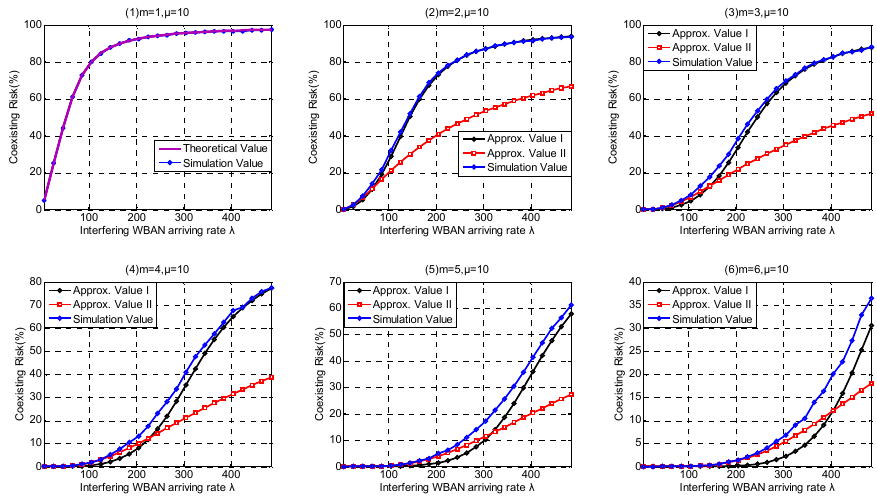
Figure 16. Coexisting Risk in Service-independent coexisting WBANs.